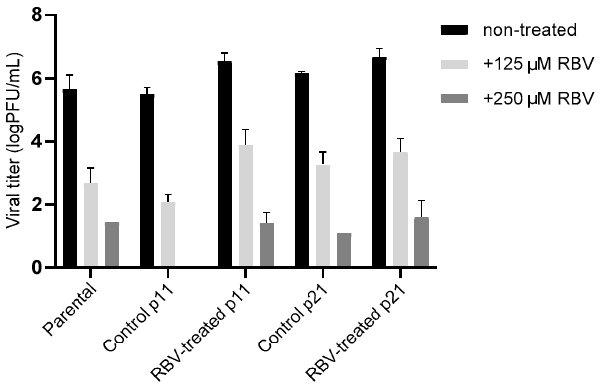
Figure 6. Resistance of passaged RBV-treated and control ZgA/Cro69 viruses to RBV. Parental, control, and RBV-treated viruses from passages 11 and 21 in A549 cells were tested for sensitivity to 125 or 250 µ M RBV in A549 cells. Titres in supernatants were determined using the plaque assay. Mean ± standard deviation obtained from 3 biological replicates are shown. Statistical significance between groups was determined using Kruskal–Wallis one-way ANOVA. There were no significant differences between different samples treated with the same RBV concentration.